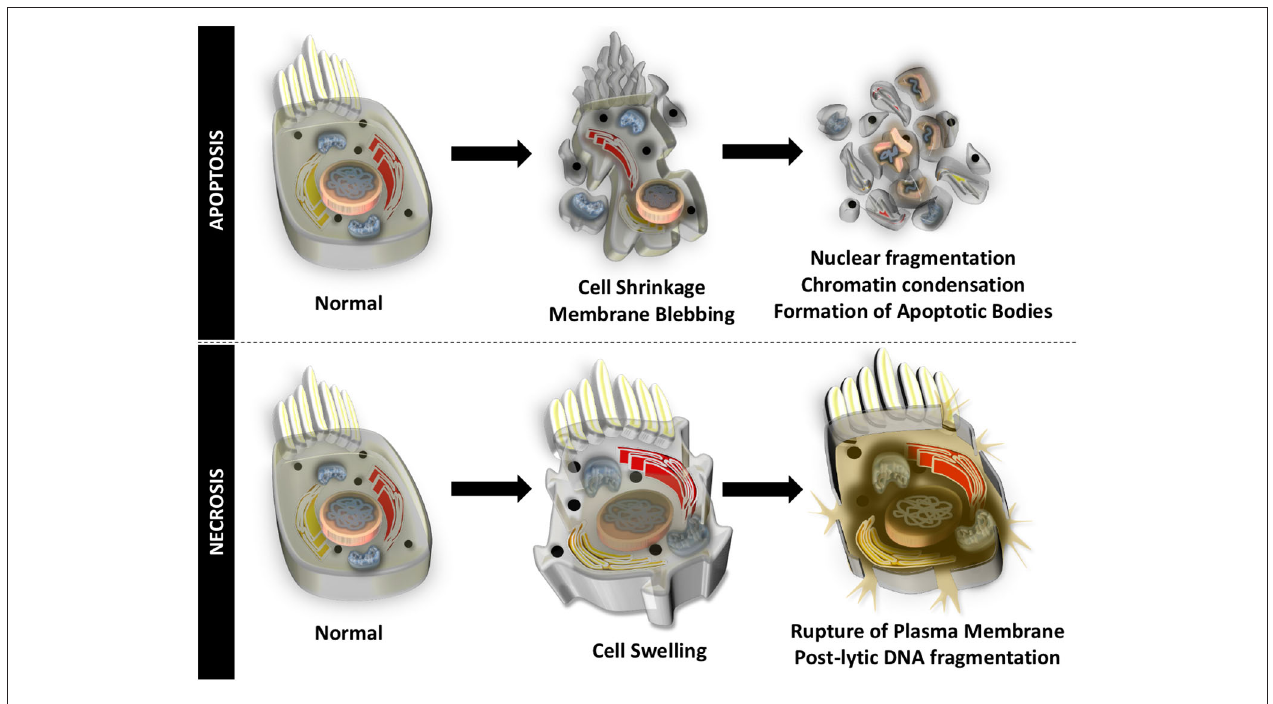
fragments (apoptotic bodies).Necrosis occurs when the volume of the cell increases, organelles swell, the plasma membrane ruptures, intracellular contents spill into the extracellular matrix, and there is postlytic DNA